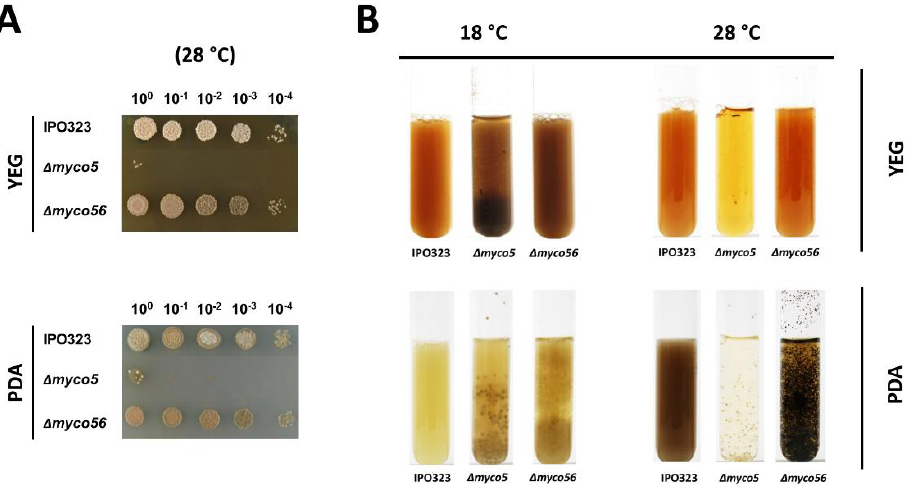
Figure 6. Growth of IPO323 and the mutant strains at elevated temperatures. ( A ) Axenic growth of Zymoseptoria tritici wild-type and generated mutant strains at increased temperature. YEG-grown cultures of the wild-type strain IPO323 and mutant strains ∆ myco5 and ∆ myco56 were spotted onto YEG/PDA plates as serial dilutions (1.5 μL; 5 × 10 7 spores/mL). Cultures were imaged following 7 days’ growth at 28 °C. ( B ) Axenic cultures of Z. tritici strains showed unusual cell aggregates and clumpy growth in the ∆ myco5 strain in PDA or YEG and for the ∆ myco56 strain in PDA. Cultures were agitated prior to imaging. Cultures for each condition were routinely incubated in 100 mL flasks, without baffles, for one week, with shaking at 120 rpm. Before imaging, strains were trans- ferred to glass tubes. For ∆ myco5 , a drastically reduced growth was apparent at elevated tempera- tures.